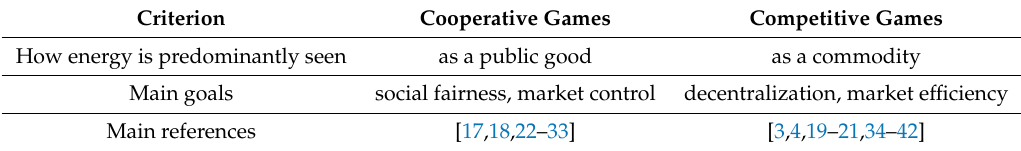
Table 1. Commercial treatment of energy and the respective approaches in the